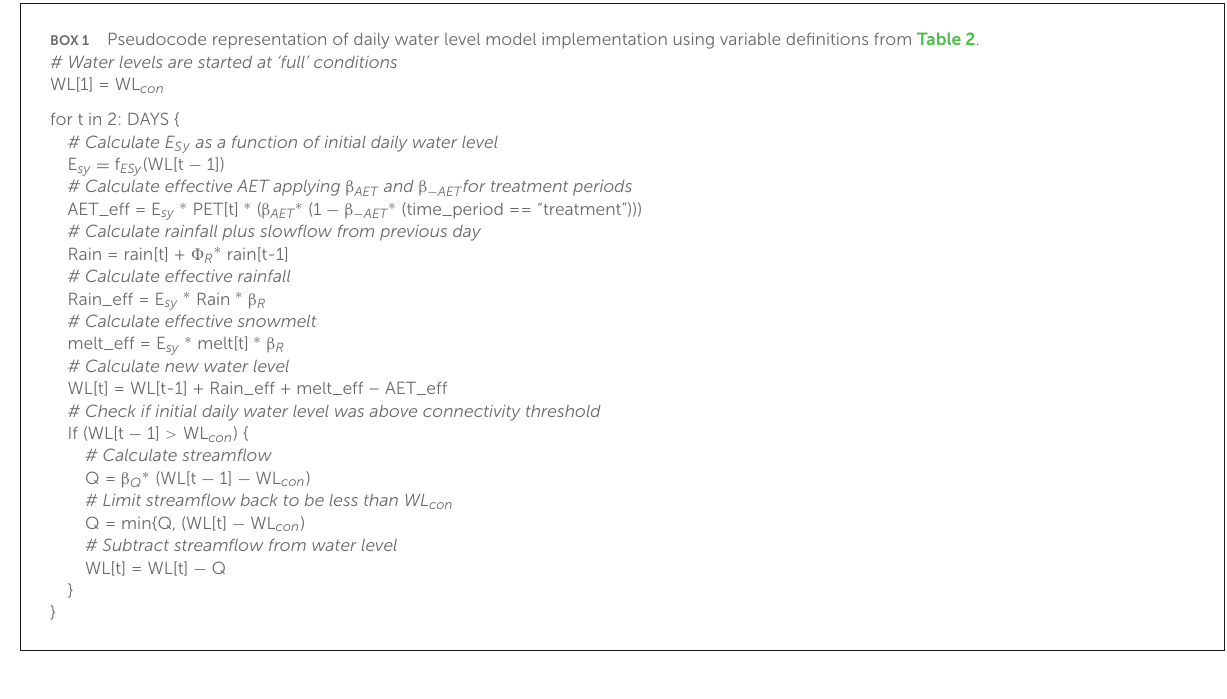
TABLE 2 Parameter notation and description for wetland water level